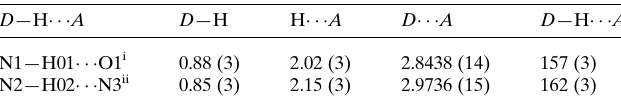
Table 2 Hydrogen-bond geometry (A˚ , (cid:2)